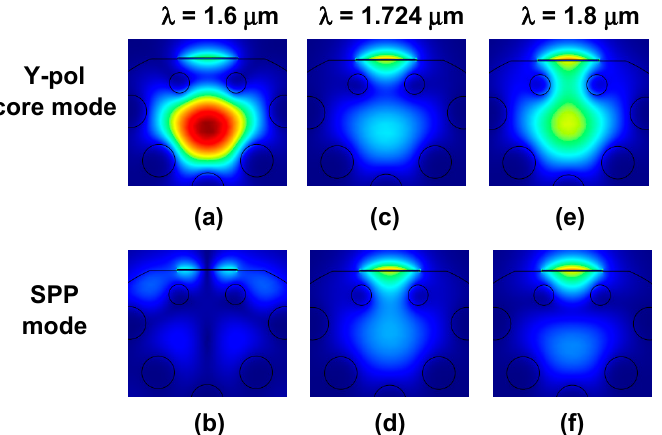
Figure 3. Light field distributions in the cross section of the MPF–SPR sensor for different wavelengths ( a – f ). The RI of the analyte is n a = 1.38.